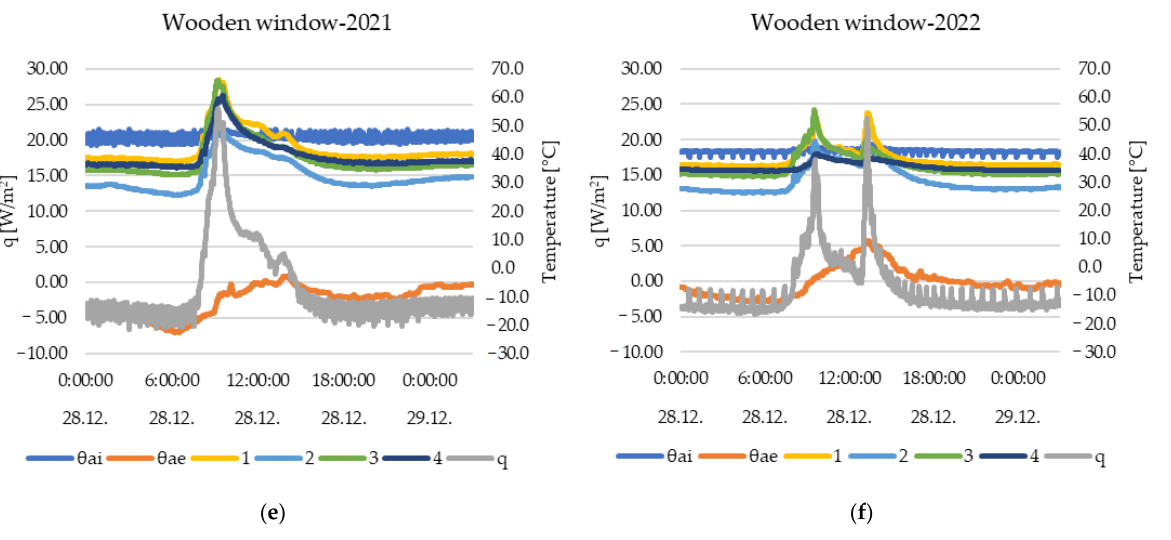
Figure 7. Measured data on all three window constructions on the selected date: ( a ) Aluminum window in 2021; ( b ) Aluminum window in 2022; ( c ) PVC window in 2021; ( d ) PVC window in 2022; ( e )Wooden window in 2021; ( f ) Wooden window in 2022.